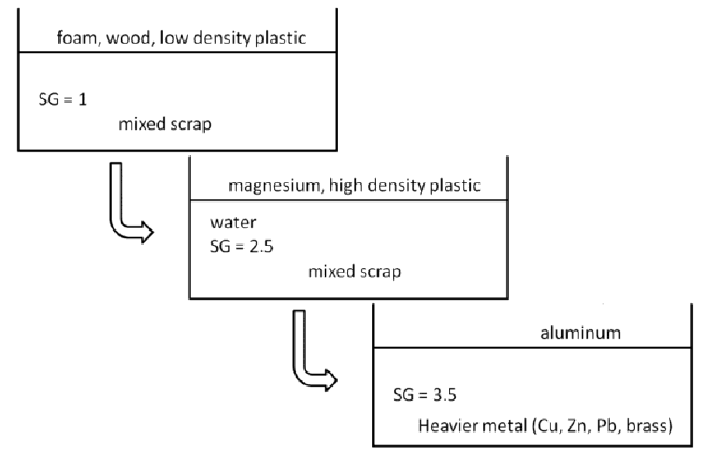
Figure 9. The three steps of sink float sorting technology with different specific gravities